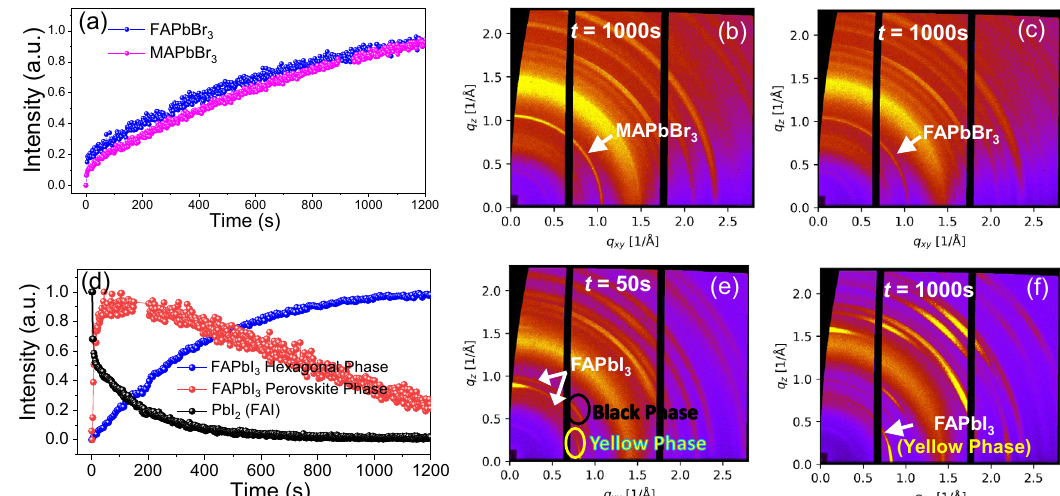
Fig. 2 Conversion reactions leading to the formation of FAPbBr 3 /MAPbBr 3 /FAPbI 3 perovskites within TiO 2 mesopores. a Absolute Bragg peak intensity against time of the measured perovskite conversion reaction: integrated intensity vs time for the formation of MAPbBr 3 and FAPbBr 3 . Reciprocal maps of b PbBr 2 + MABr and c PbBr 2 + FABr perovskite reactions after 1000 s. Broad ring around 1.5 (1/Å) is attributed to the isopropyl alcohol solvent. d Absolute Bragg peak intensity against time of the PbI 2 + FAI perovskite conversion reaction: integrated intensity vs time of consumption of PbI 2 (solid black colour) and formation of trigonal (solid red colour) and hexagonal phases of FAPbI 3 (solid blue colour). e , f Reciprocal maps of the PbI 2 + FAI perovskite reaction after e 50 s and f 1000 s after the solution was added. The image at 50 s shows Bragg peaks corresponding to both trigonal (black) and hexagonal (yellow) phases of FAPbI 3 . After 1000 s, the peaks of the trigonal phase have almost disappeared while the peaks of the hexagonal (yellow) phase have intensi fi